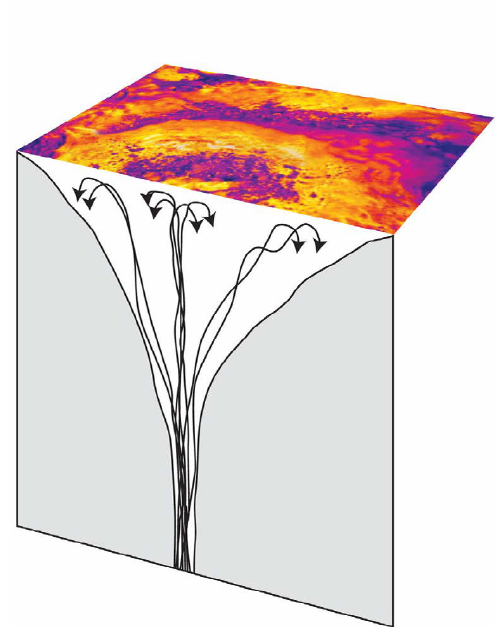
Figure 14: A thermal orthomosaic (2015) of the crater area of the LUSI mud eruption, projected on a 3-D cartoon depicting the envisaged subsurface convection cells (not to scale). The concentric rings observed in the central zone illustrate hotter regions (orange and yel- low) alternating with colder (purple colour) areas. Di- ameter of the clear hotter ring is ~100 m. Data were ac- quired with a FLIR I7 thermal camera mounted on the LUSI drone (a DJI Spreading Wings S800 hexacopter [Di Stefano et al. 2018]). Redrawn from Di Felice et al.